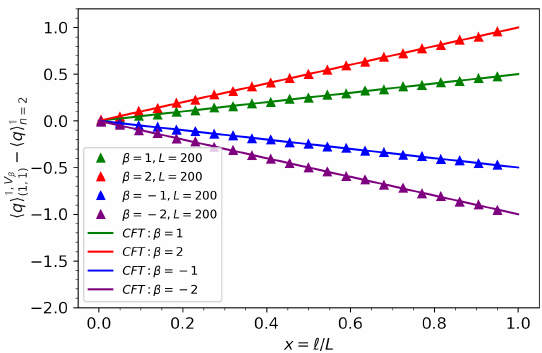
1 ,V as a function of x = ‘/L for different values β − h q i 1 2 (1 , 1)